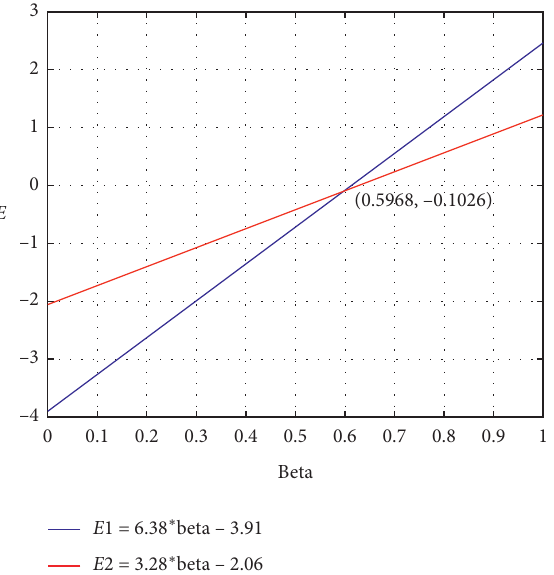
Figure 9: Function graphs of E B